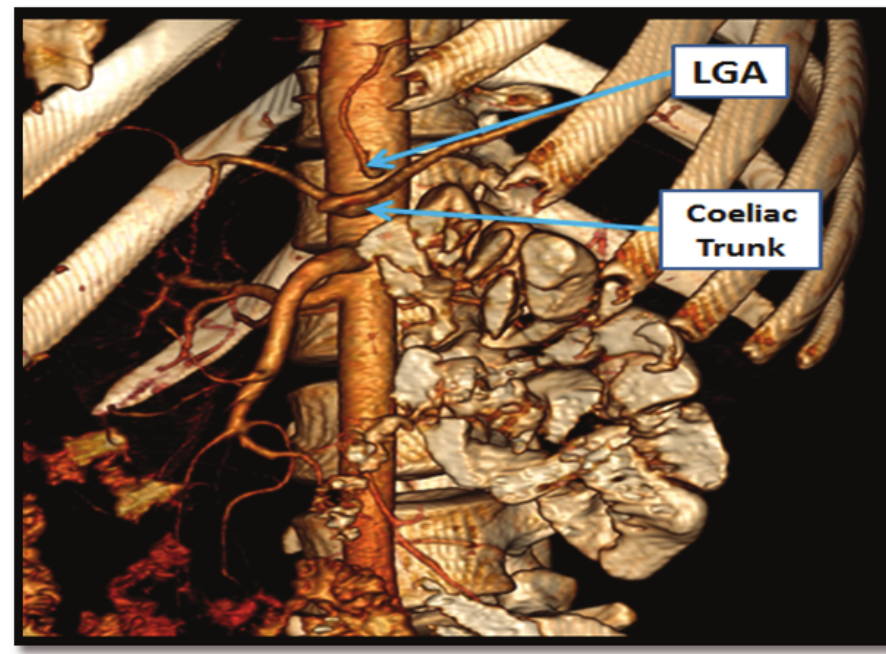
Figure 5 : CT angiography of Toshiba Aquilion 𝑇𝑀 64 slice (Toshiba Medical Systems, Nasu, Japan) showing the LGA arising directly from the aorta.